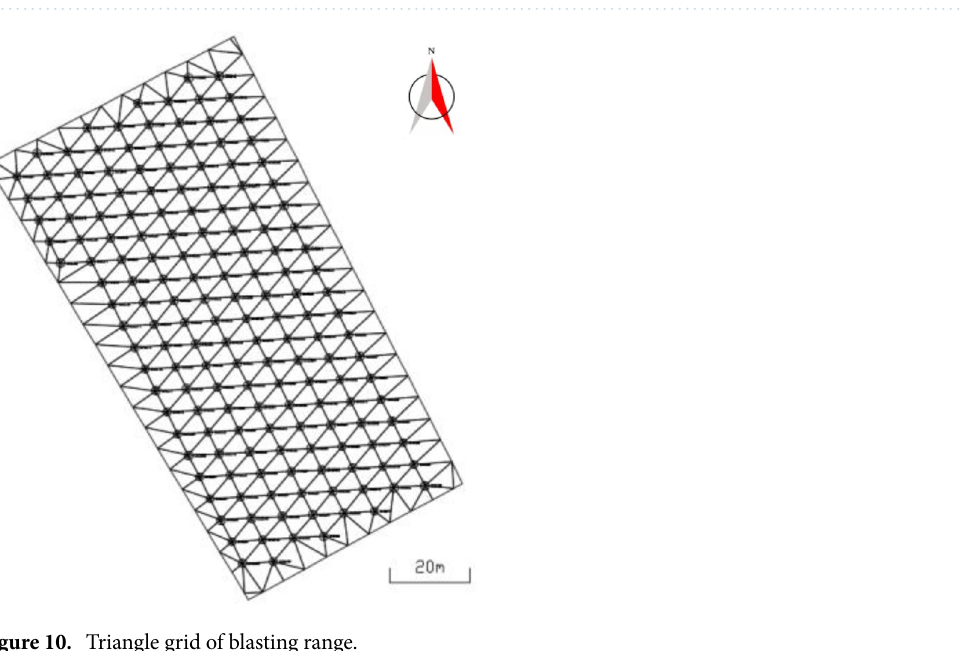
Figure 9. Stope cutting process: ( a ) stope triangle grid; ( b ) blasting 3D solid model after cutting.